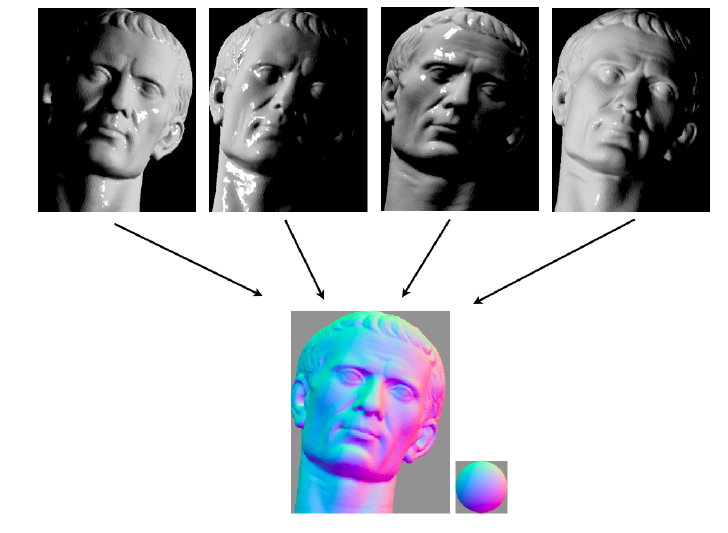
Figure 9. Photometric stereo setup: four lights are used to illuminate an underwater scene. The same scene with lighting from different sources results in the images used to recover three-dimensional information